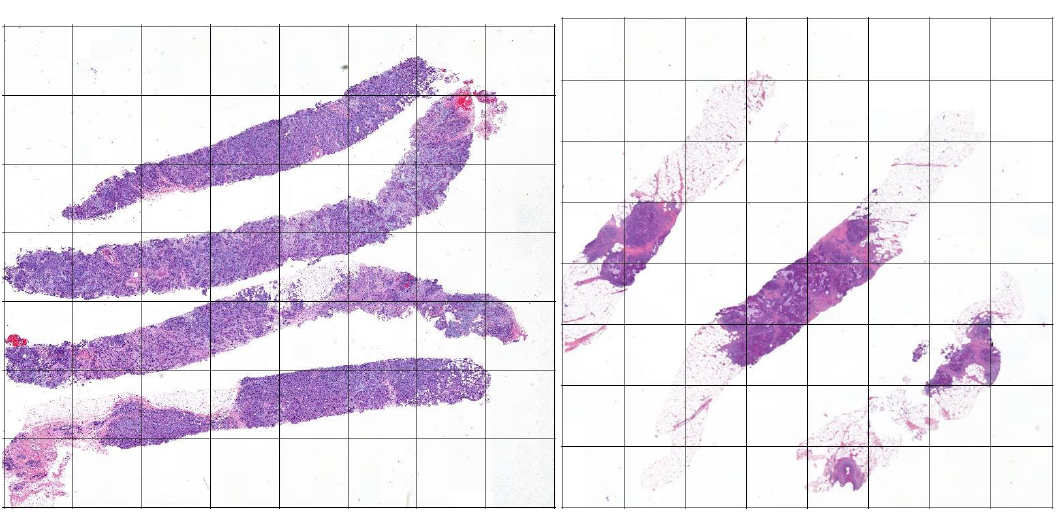
Figure 3. An example of slides from our dataset in which we applied a rectangular grid (shown with the continuous black lines) to show the division of a slide in